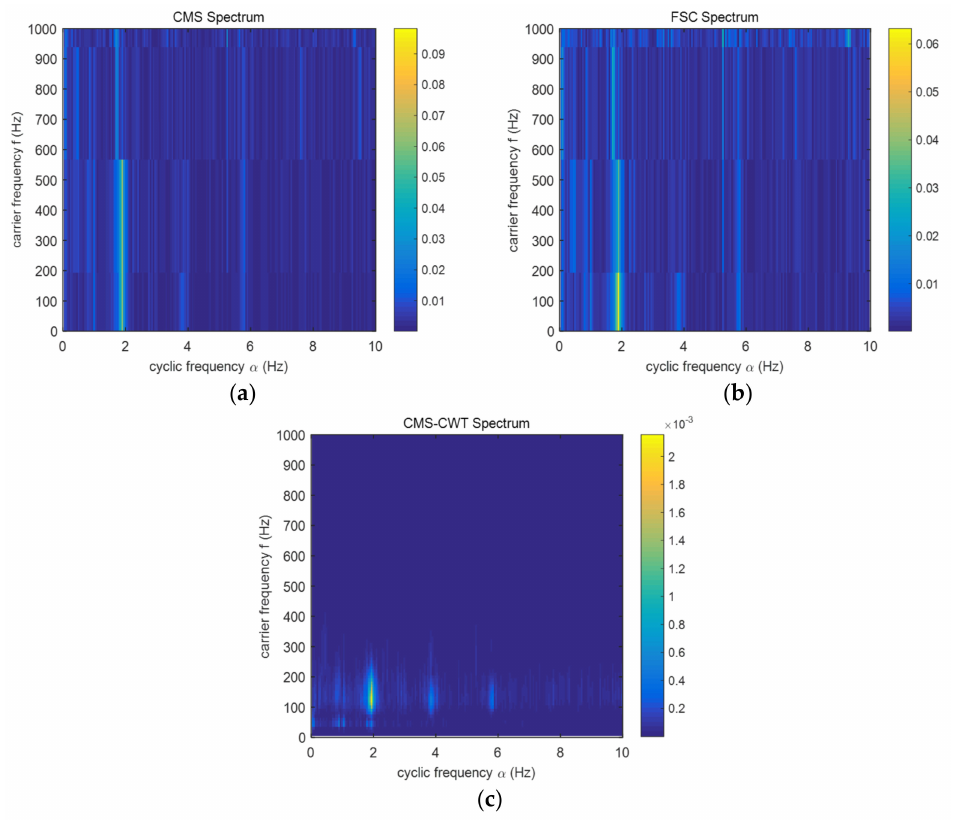
Figure 10. Carrier frequency identification capability of ( a ) CMS, ( b ) FSC, and ( c ) CMS-CWT for the one broken bar case under 40% load.